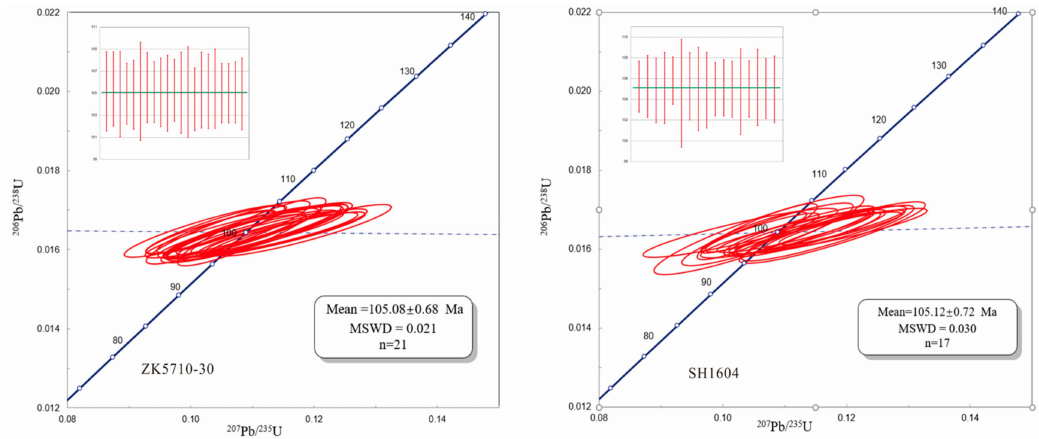
Figure 5. Zircon U–Pb concordia diagrams and weighted mean ages for rock samples SH1604 and ZK5710-30 from the Zijinshan ore